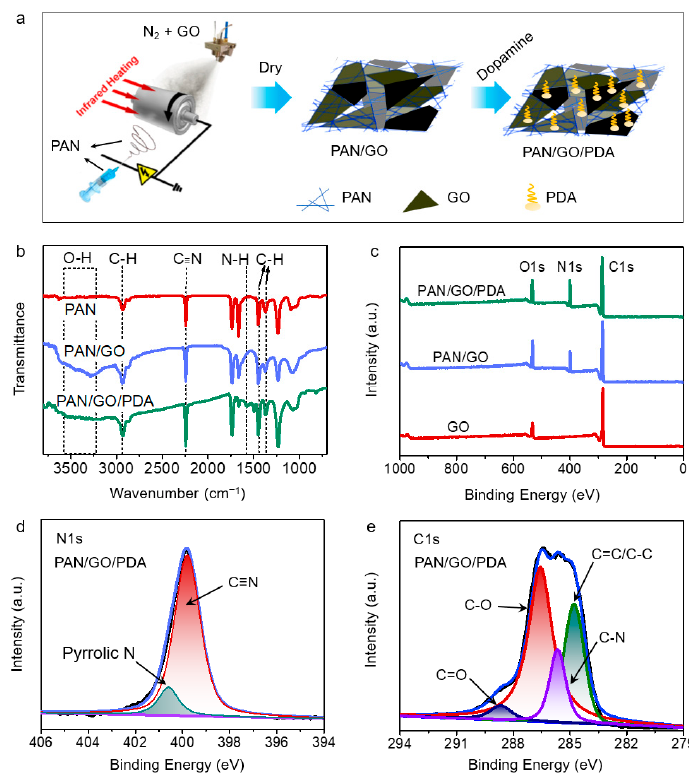
Figure 1. ( a ) Scheme of the synthetic route for the PAN/GO/PDA membrane. ( b ) ATR-FTIR spectra for the PAN, PAN/GO, and PAN/GO/PDA membranes. ( c ) XPS survey spectra of the PAN, PAN/GO, and PAN/GO/PDA membranes. ( d ) High-resolution image of N1s and ( e ) C1s XPS spectra for the PAN/GO/PDA